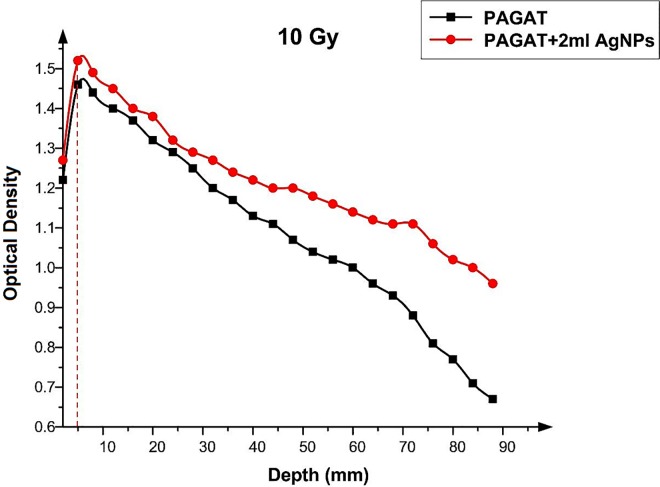
OD versus depth in the PAGAT polymer gel and PAGAT with Ag nanoparticles iraddiated by 10 Gy of 60Co.